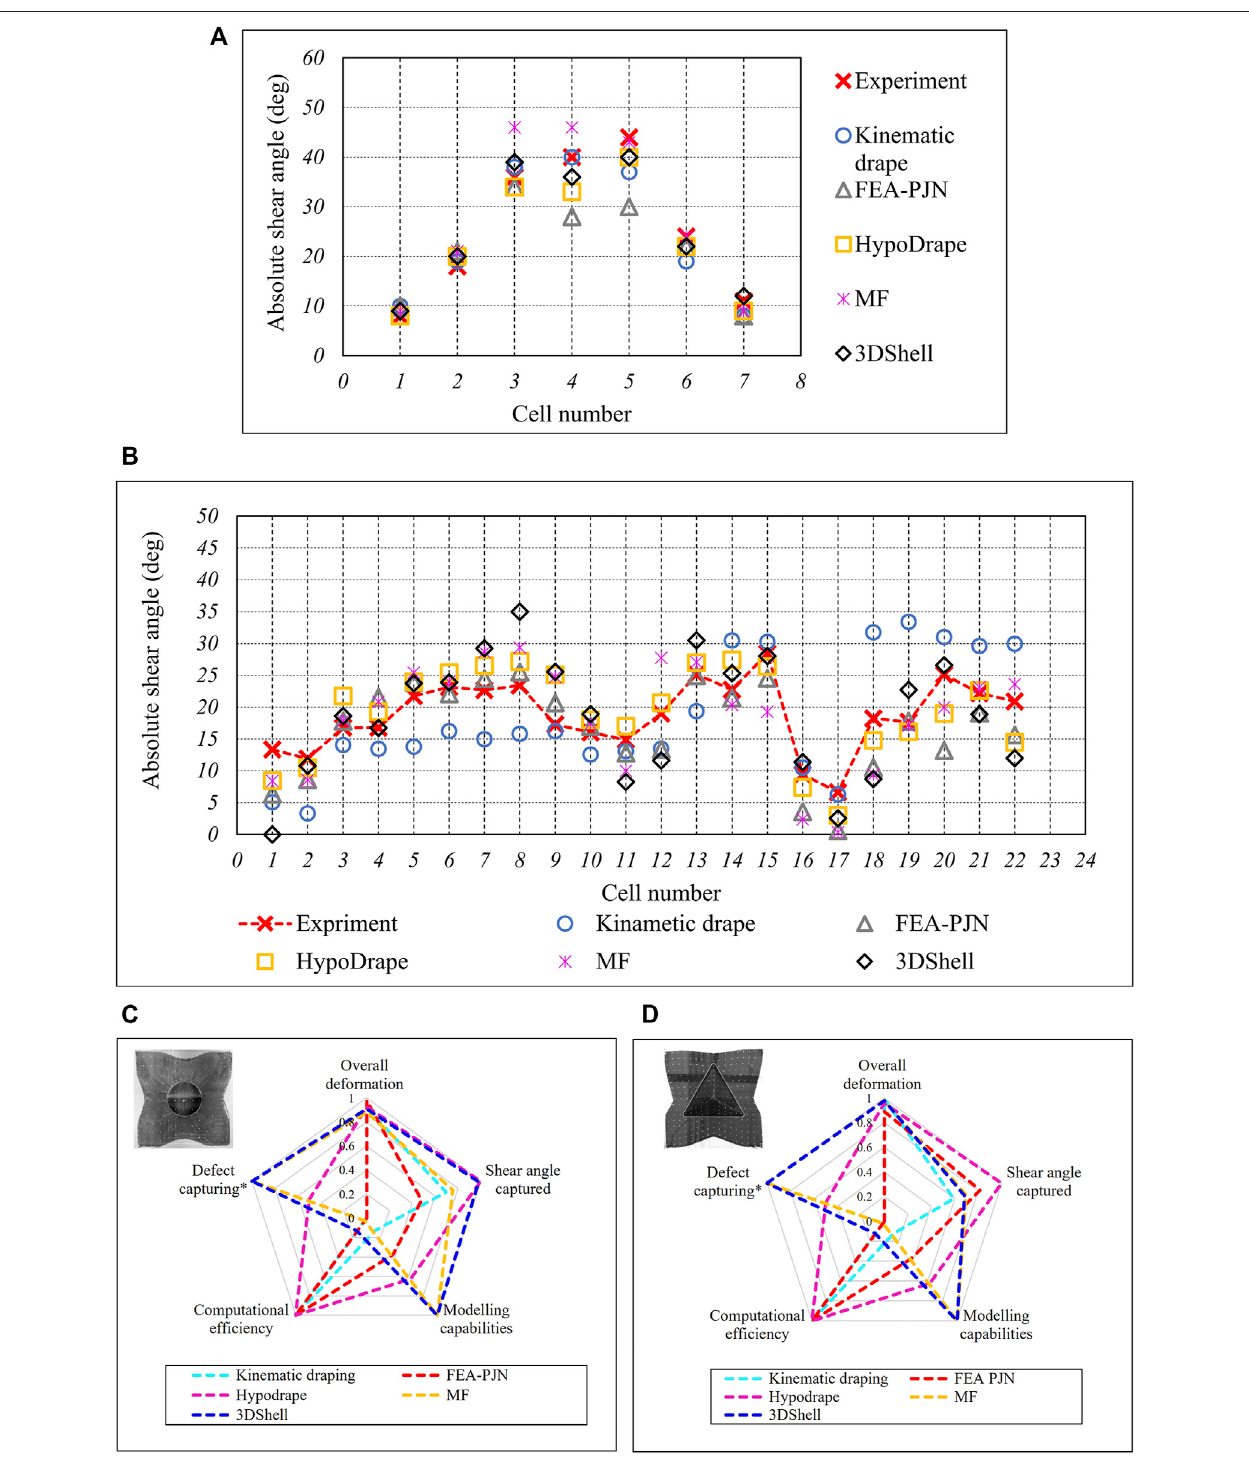
FIGURE10 | Shear angle comparison between experiment and modelling resutls in (A) hemisphere and (B) tetrehedron forming. Note thatmeasuringcell number isspeci fi edin Figure4 .Radarchartsofmodellingperformanceofallmodelsin (C) hemisphericformingand (D) tetrahedronforming.(*:expectations basedonmodelling